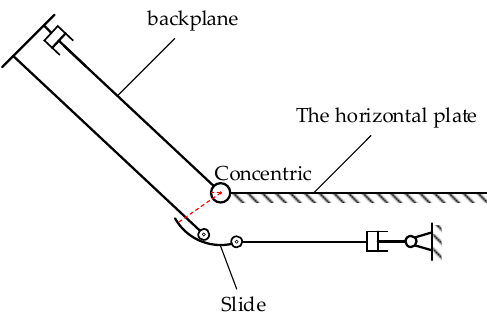
Figure 4. Mechanism motion diagram of the moving panel.